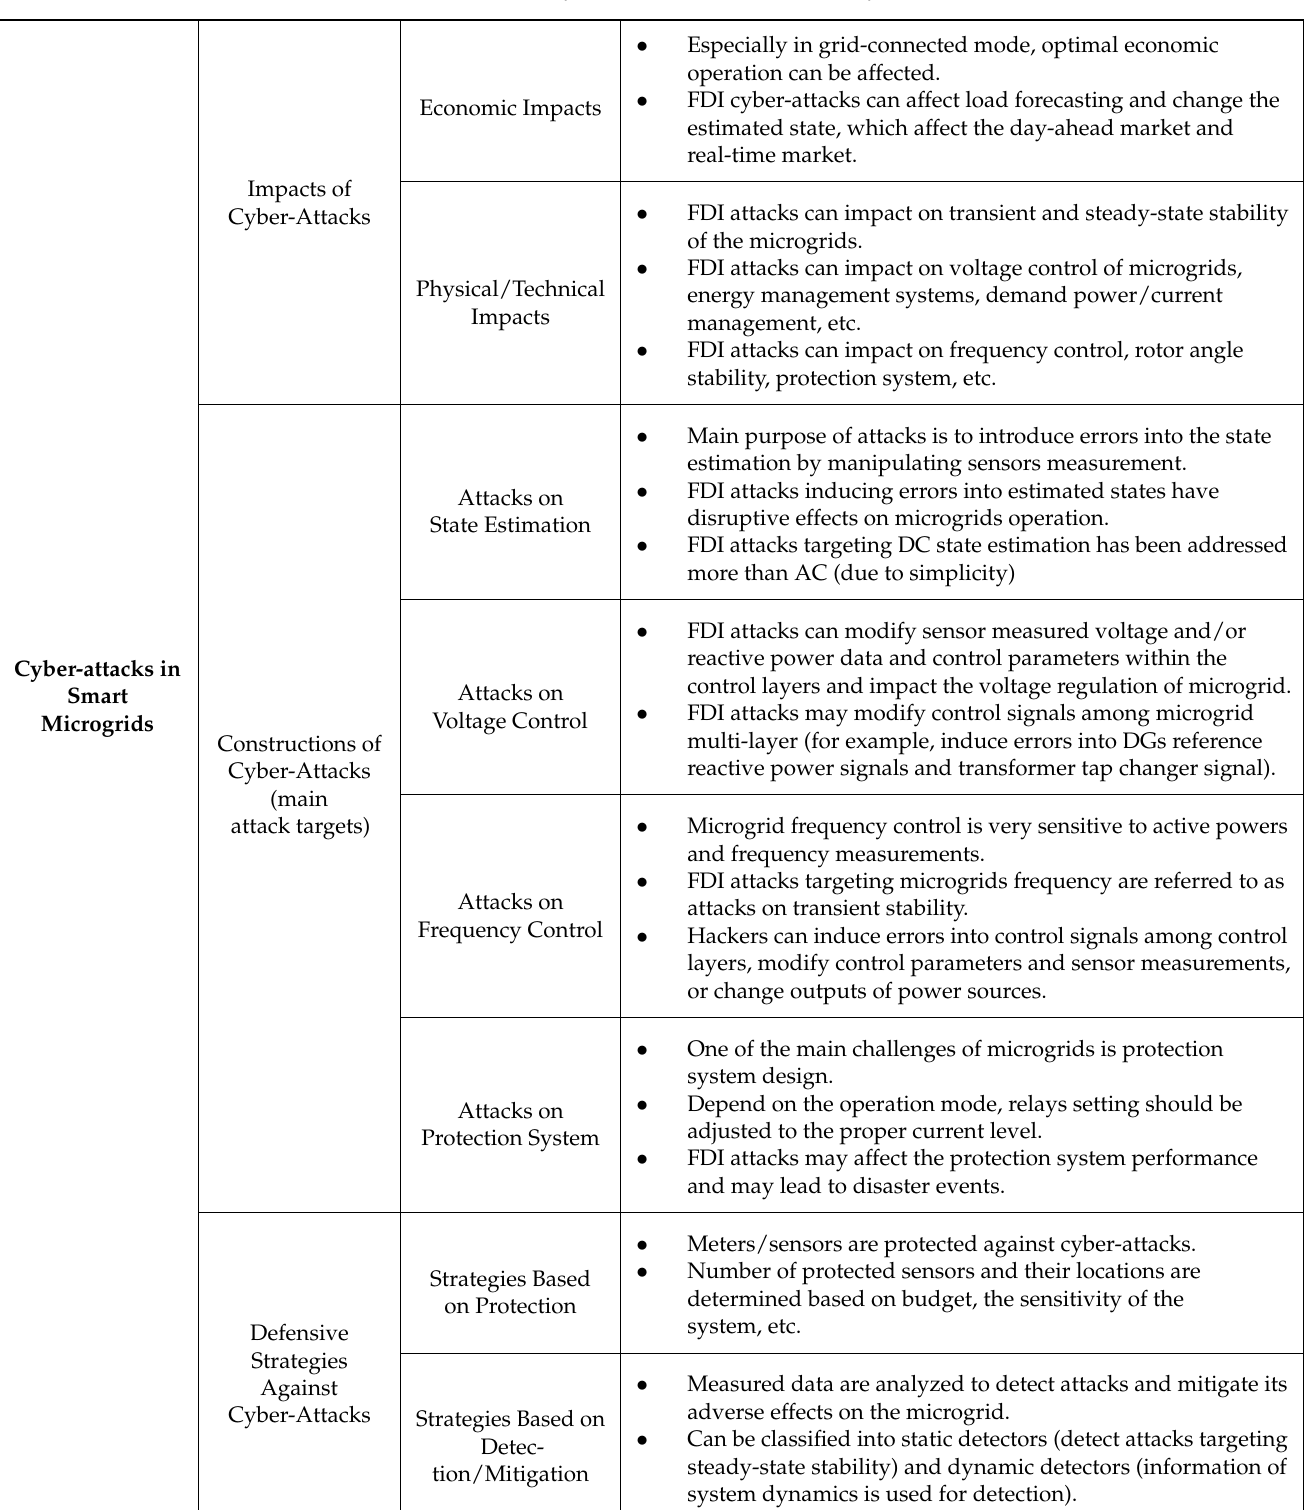
Table 2. Review of Cyber-Attacks in Smart Power